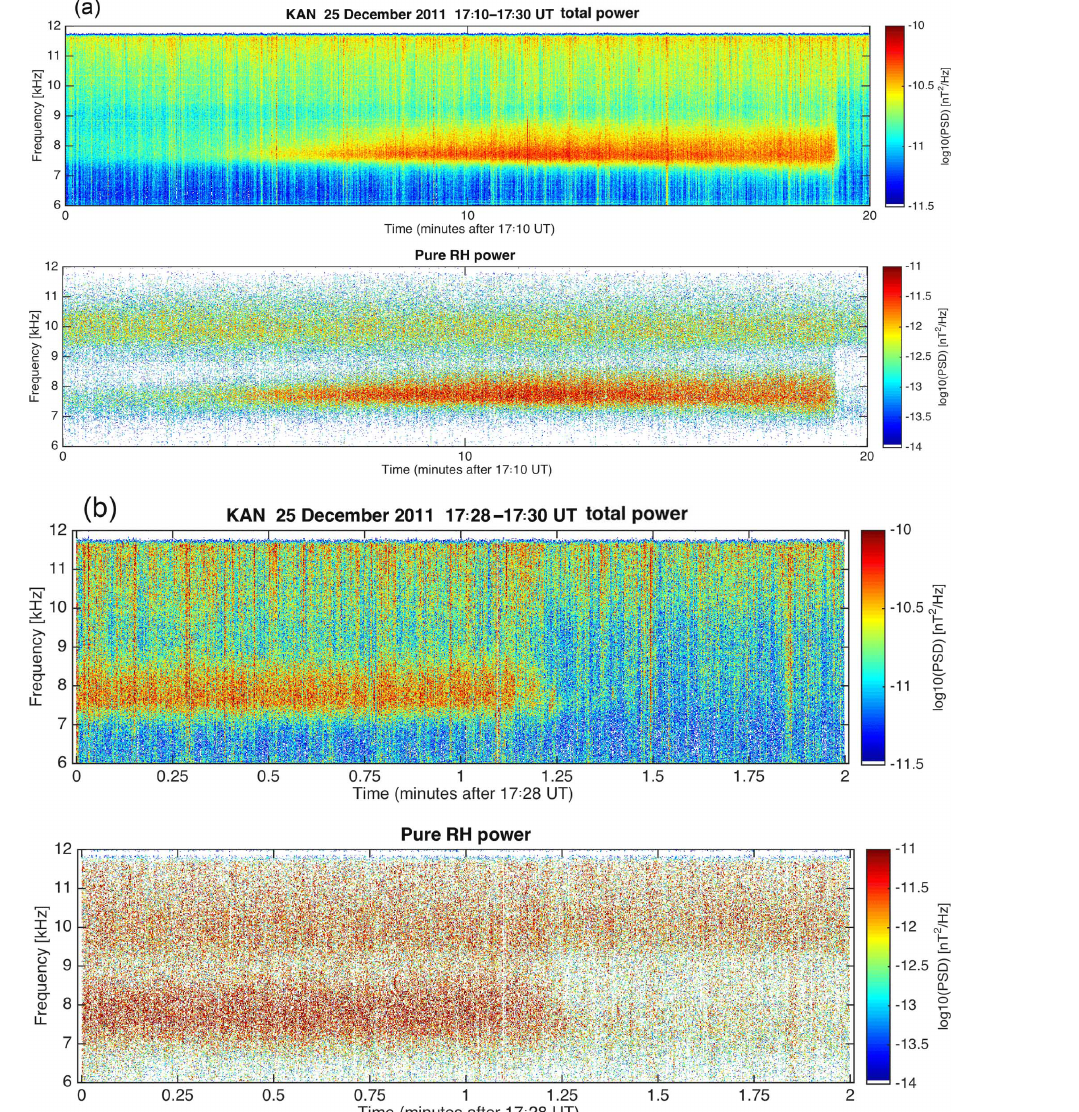
Figure 3. (a) The 6–12kHz VLF spectrograms (total and right-handed powers) of one individual element (“bullet”) of QP emissions at 17:10–17:30UT on 25 December 2011. (b) Same event as in Fig. 3a., but only lasting 2min